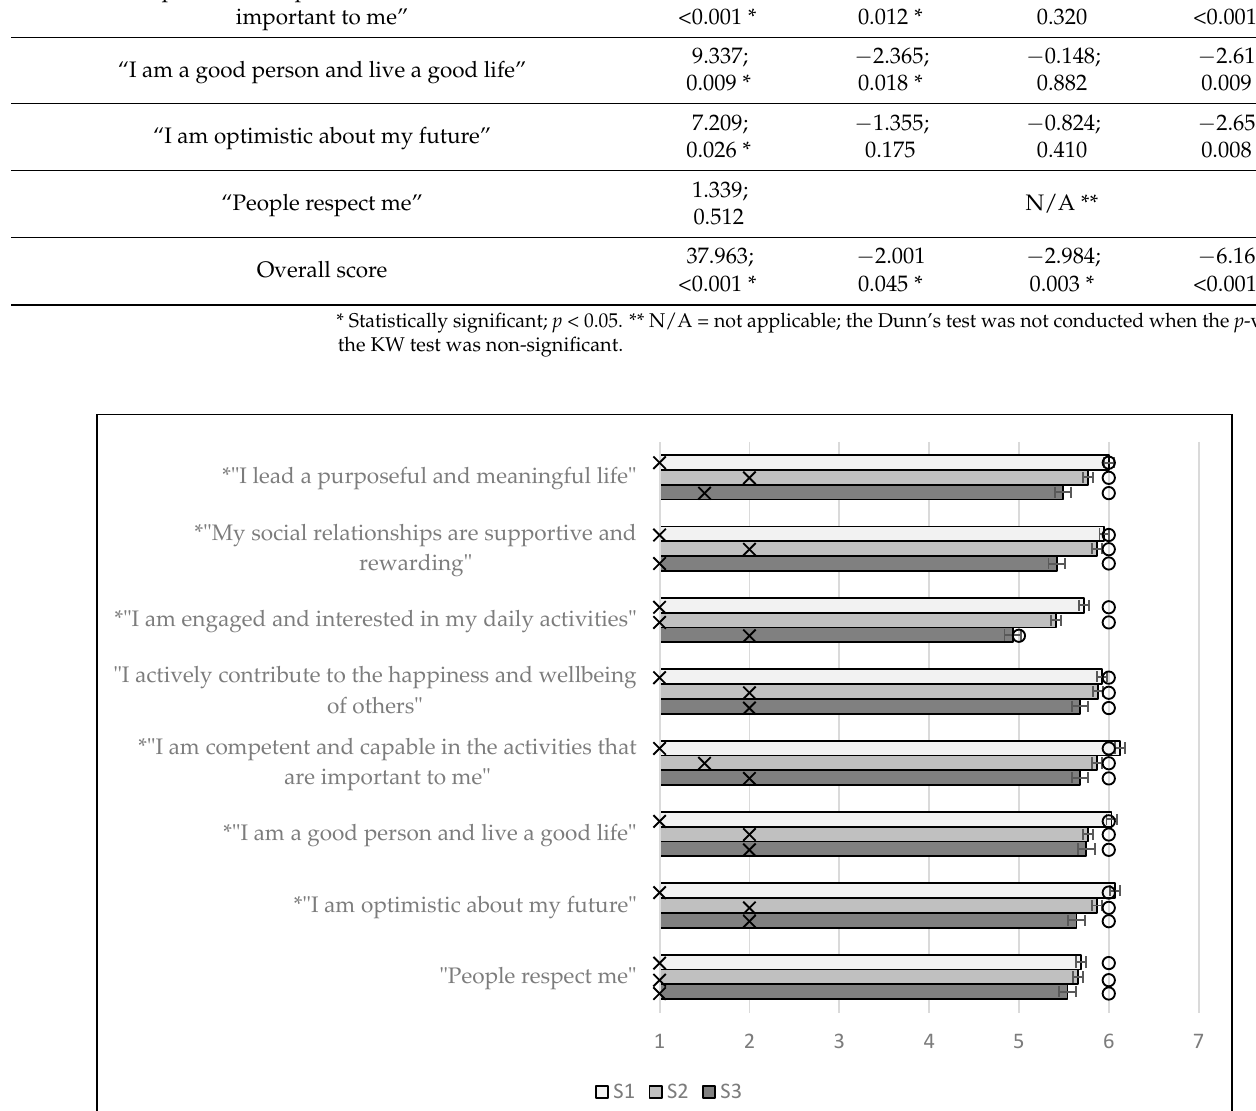
Figure 2. Means and standard error bars for the individual items of the FS; the IQR is represented by an ‘x’, the median by a circle and an asterisk indicates a statistically significant difference in one or more groups.